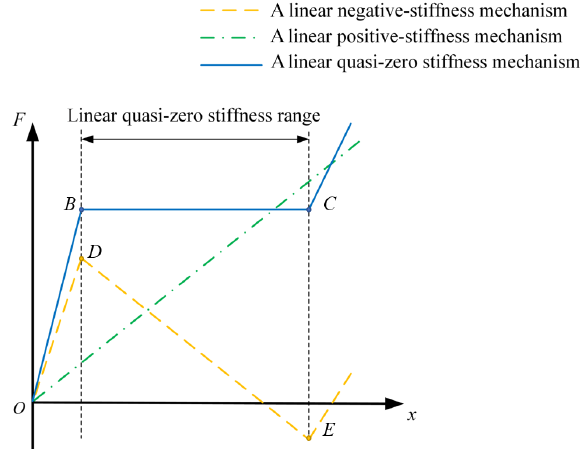
Figure 1. Illustration of a linear quasi-zero stiffness mechanism consisting of a linear positive-stiffness compliant mechanism in par- allel with a linear negative-stiffness compliant